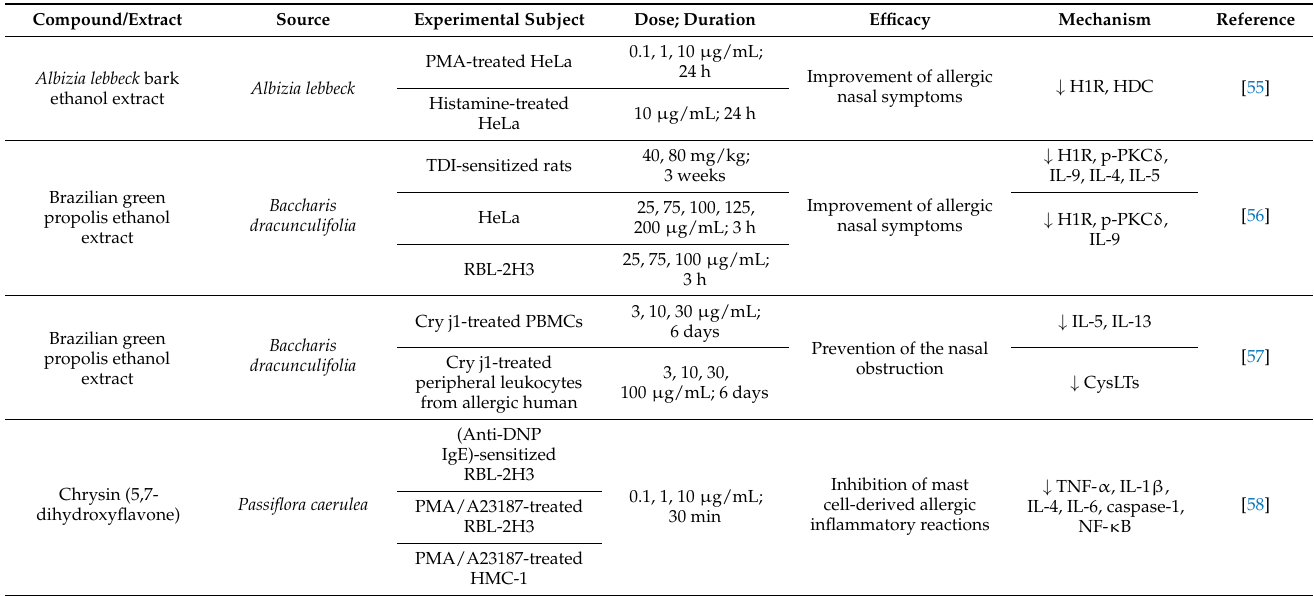
Table 1. In vitro studies—plant-originated natural